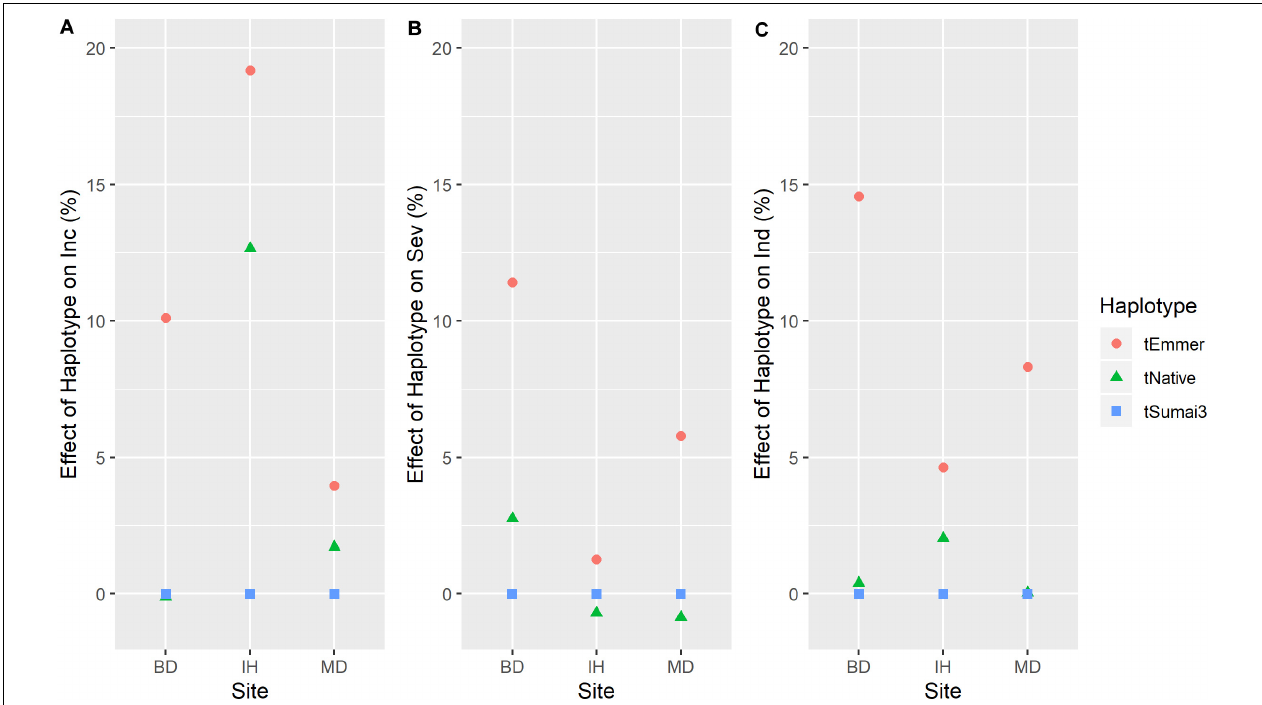
FIGURE 6 | Haplotype effects (mean values across years in each site) of Fhb1 (3BS.2) QTL on (A) FHB incidence (Inc); (B) FHB severity (Sev); and (C) FHB index (Ind). Three types of haplotype were identified and defined as tEmmer, tNative and tSumai3. Site: BD, Brandon, MB; IH, Indian Head, SK; and MD, Morden, MB. Y -axis, effects of haplotype on disease susceptibility, larger number indicates that haplotype increases disease